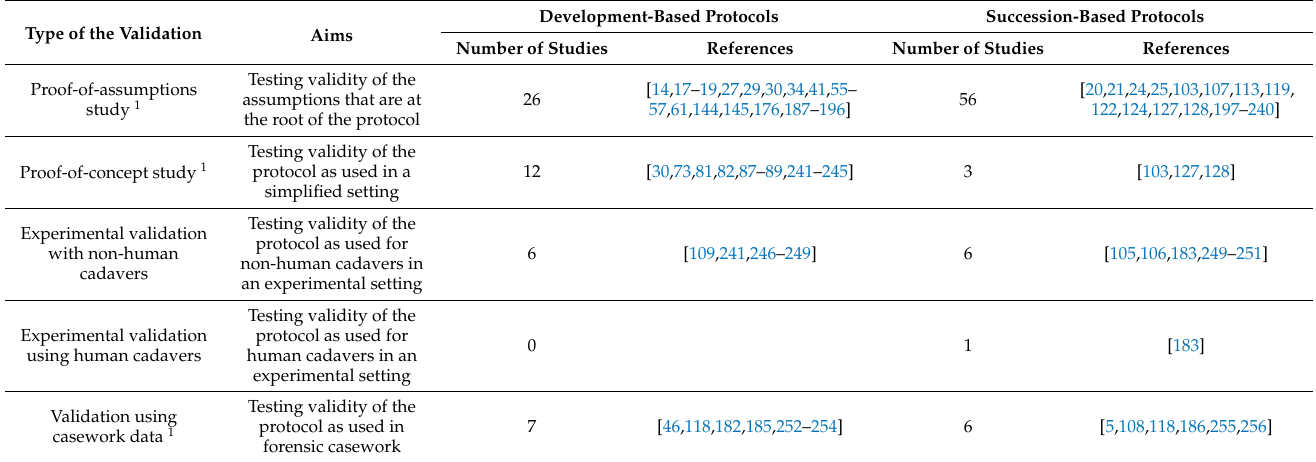
Table 4. Validation of the protocols for the estimation of PMI based on insect